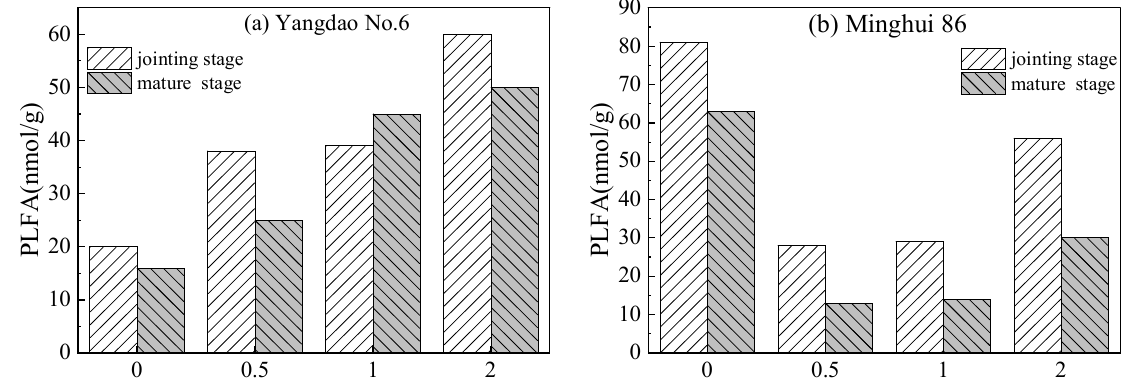
Figure 8. Absolute content of PLFA at jointing stage and mature stage of two kinds of rice.